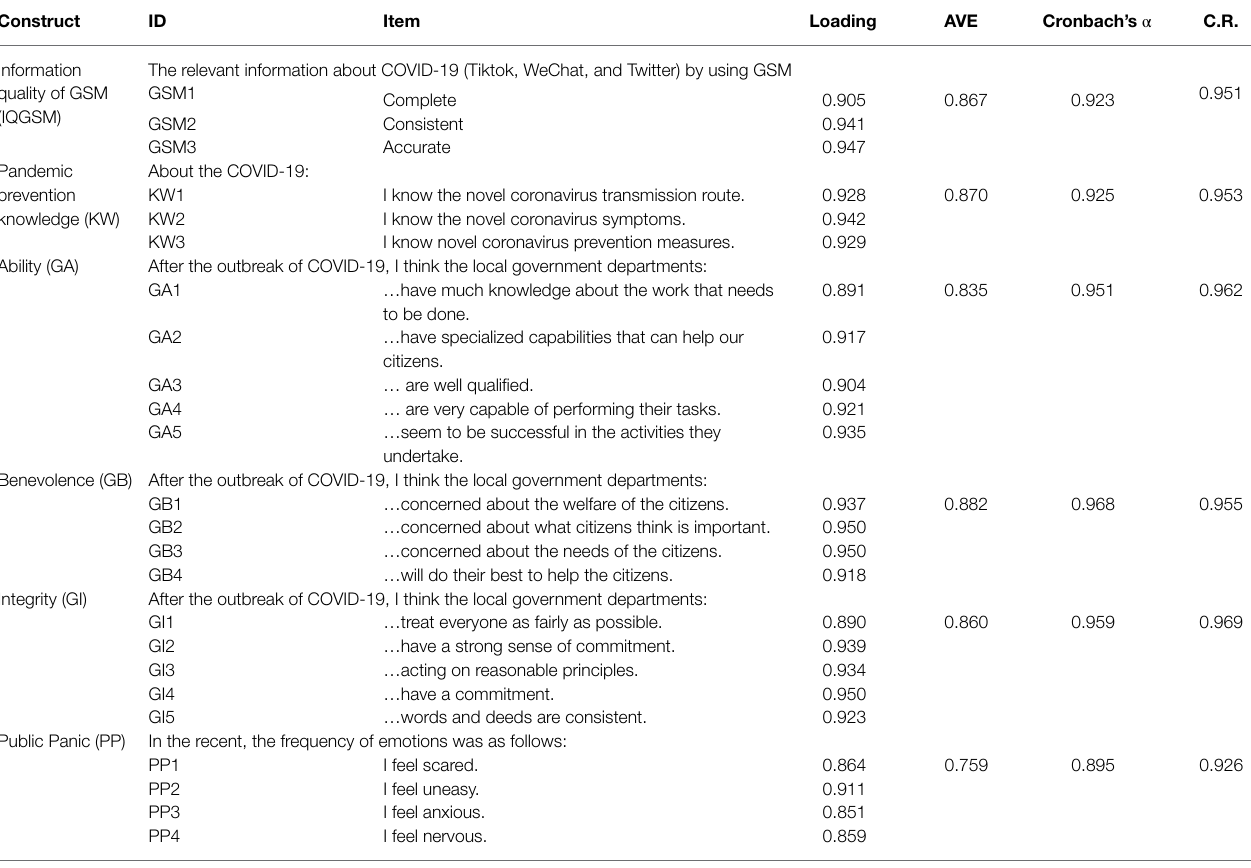
TABLE 1 | Reliability and validity. Construct